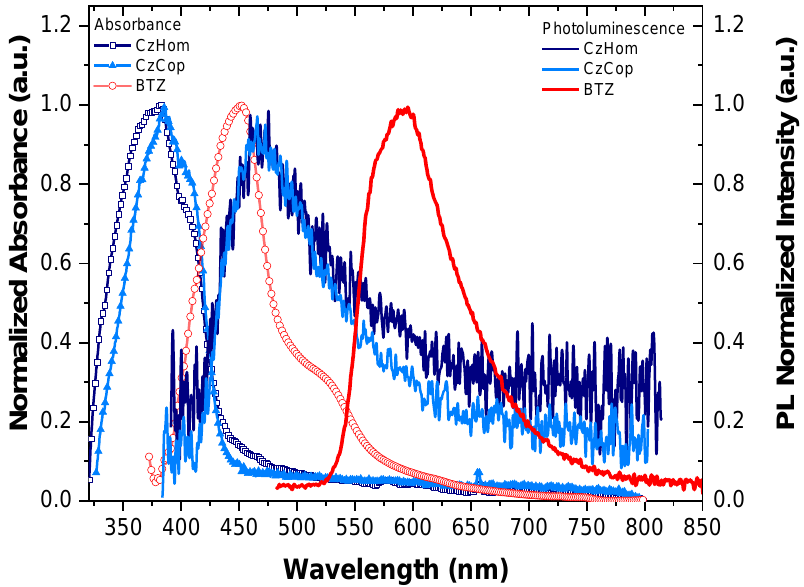
Figure 5. Absorption and PL spectra of CzHom, CzCop and BTZ monomer. The PL emission spectra of CzHom, CzCop, BTZ and WCop thin films, recorded upon excitation at 370 nm, are illustrated in Figure 6. For their better evaluation, a deconvolution